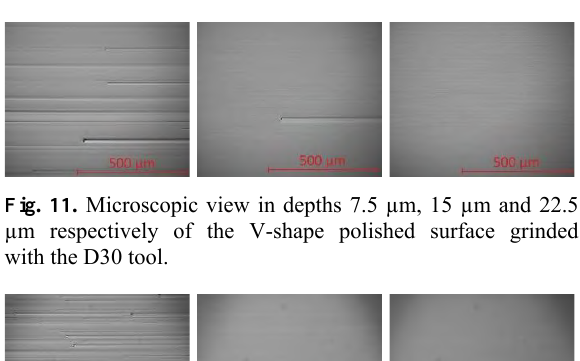
Fig . 10 . Microscopic view in depths 10 µm, 20 µm and 30 µm respectively of the V-shape polished surface grinded with the D64 tool.